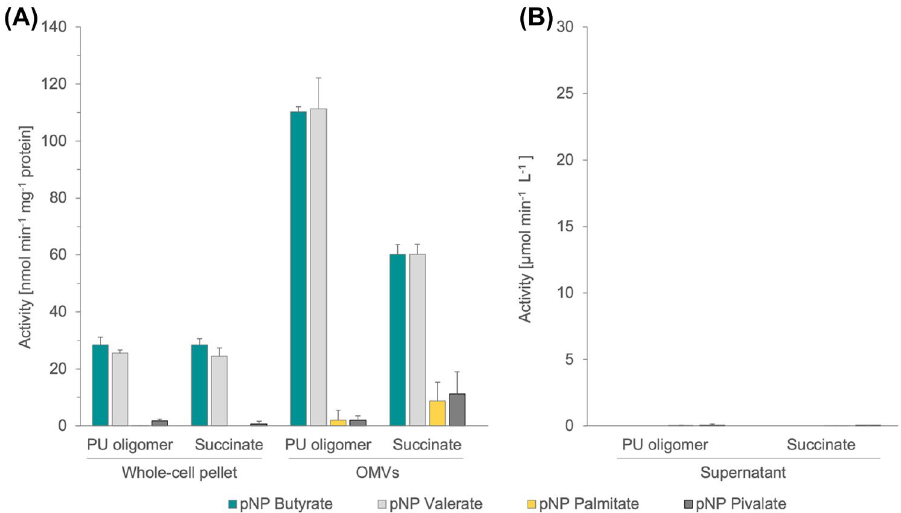
Figure 3. Conversion of p -nitrophenyl esters to p- nitrophenol by different fractions of P. capeferrum TDA1 grown in PU oligomer, or succinate (control). ( A ) Esterase/Lipase activity on whole-cell pellets and outer- membrane vesicles (OMVs) (per mg protein) and ( B ) supernatants (per volume) of P. capeferrum TDA1 were assessed. OMV samples were subjected to a protein quantification via BRADFORD. Standard deviations and legend are